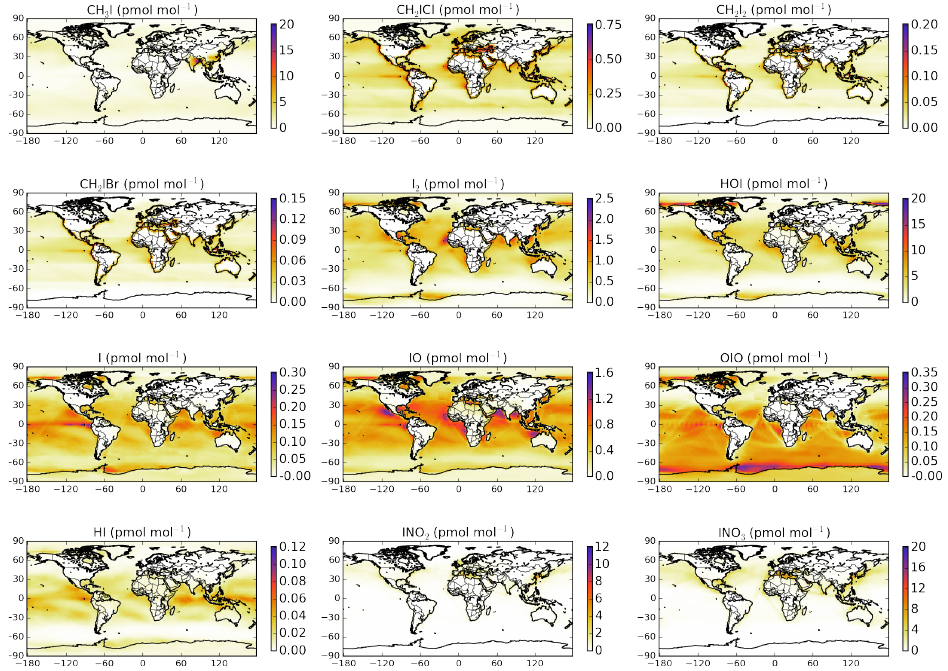
Figure 3. Annual mean surface mixing ratios for precursor and reactive iodine (pmolmol − 1 ) in the simulation with both iodine and bromine chemistry (“Br + I”).